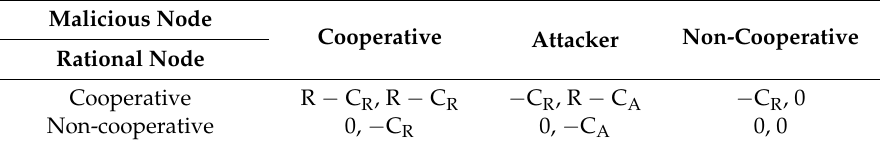
Table 1. Profit matrix for forwarding